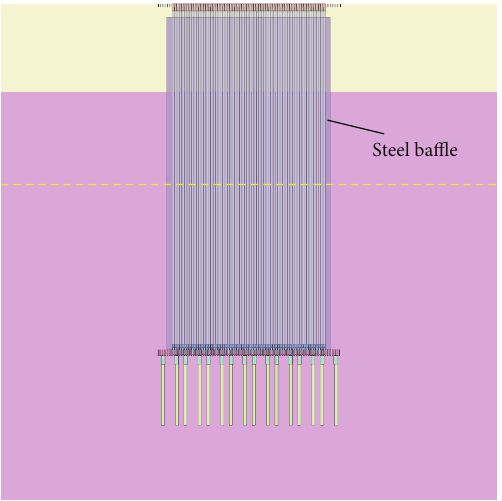
Figure 4: Axial view of DIMPLE S06B.